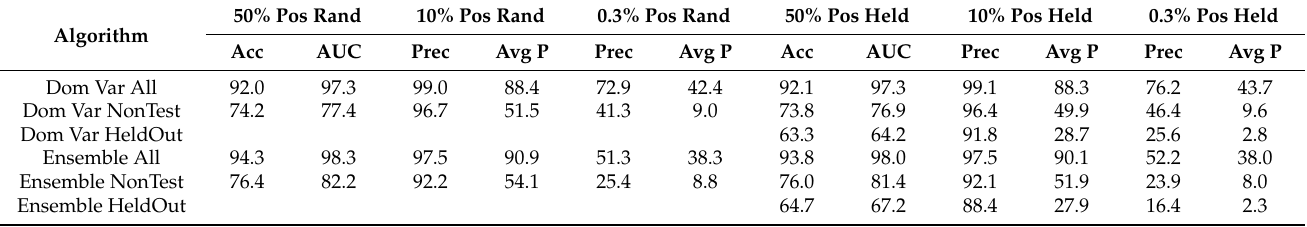
Table 8. Accuracy of a domain feature predictor (Zhang 2016 Domain Variant) and ensemble (Simple Ensemble) predictor using all interactions, non-test interactions, and non-held out protein pair interactions when computing features. Held out protein pairs are not valid for datasets created by selecting random pairs. The accuracy of these predictors drops significantly when removing the test interactions from the feature creation process.